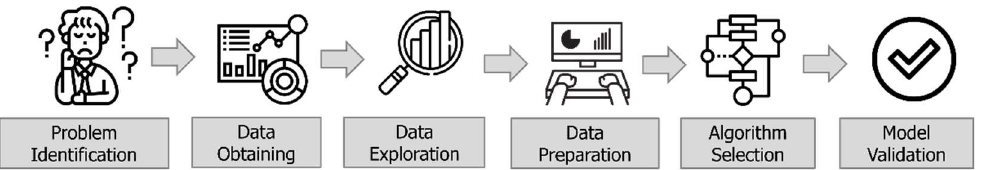
Figure 3. Common steps for trying out a machine learning project. These steps were used in the development of this work (adapted from [28]).